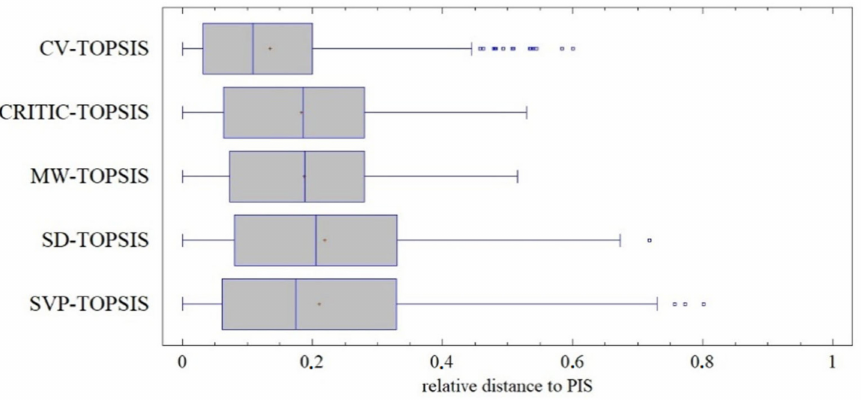
Figure 11. Box plot of results obtained (TOPSIS combined with CV, CRITIC, MW, SD and